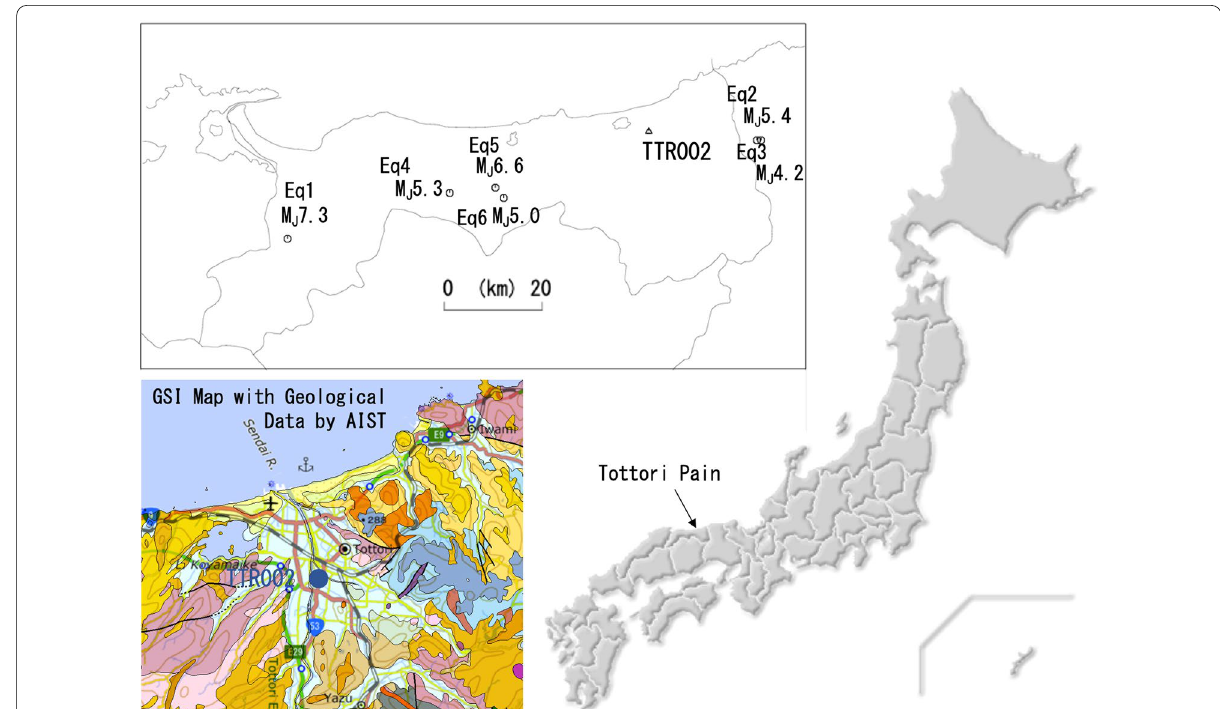
Fig. 1 Location of Tottori plain and target site TTR002 with epicenter distribution of earthquakes used in the study. Earthquake numbers are common with those in Fig. 2a. Geological map in left bottom panel shows the area of Tottori plain (lime